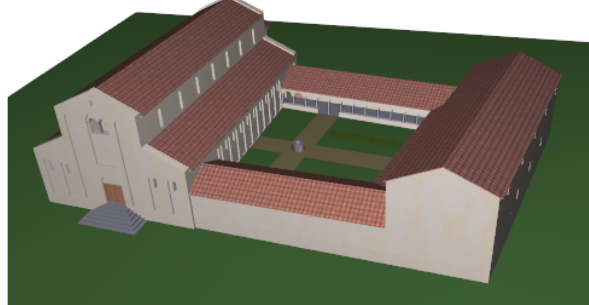
Figure 2. 3D virtual reconstruction of Saint John abbey,